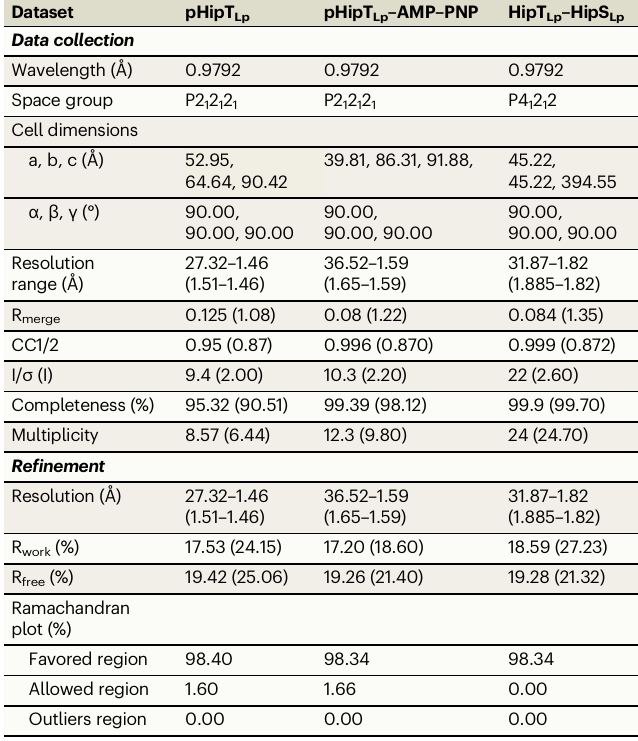
Table 1 | X-ray data collection and re fi nement